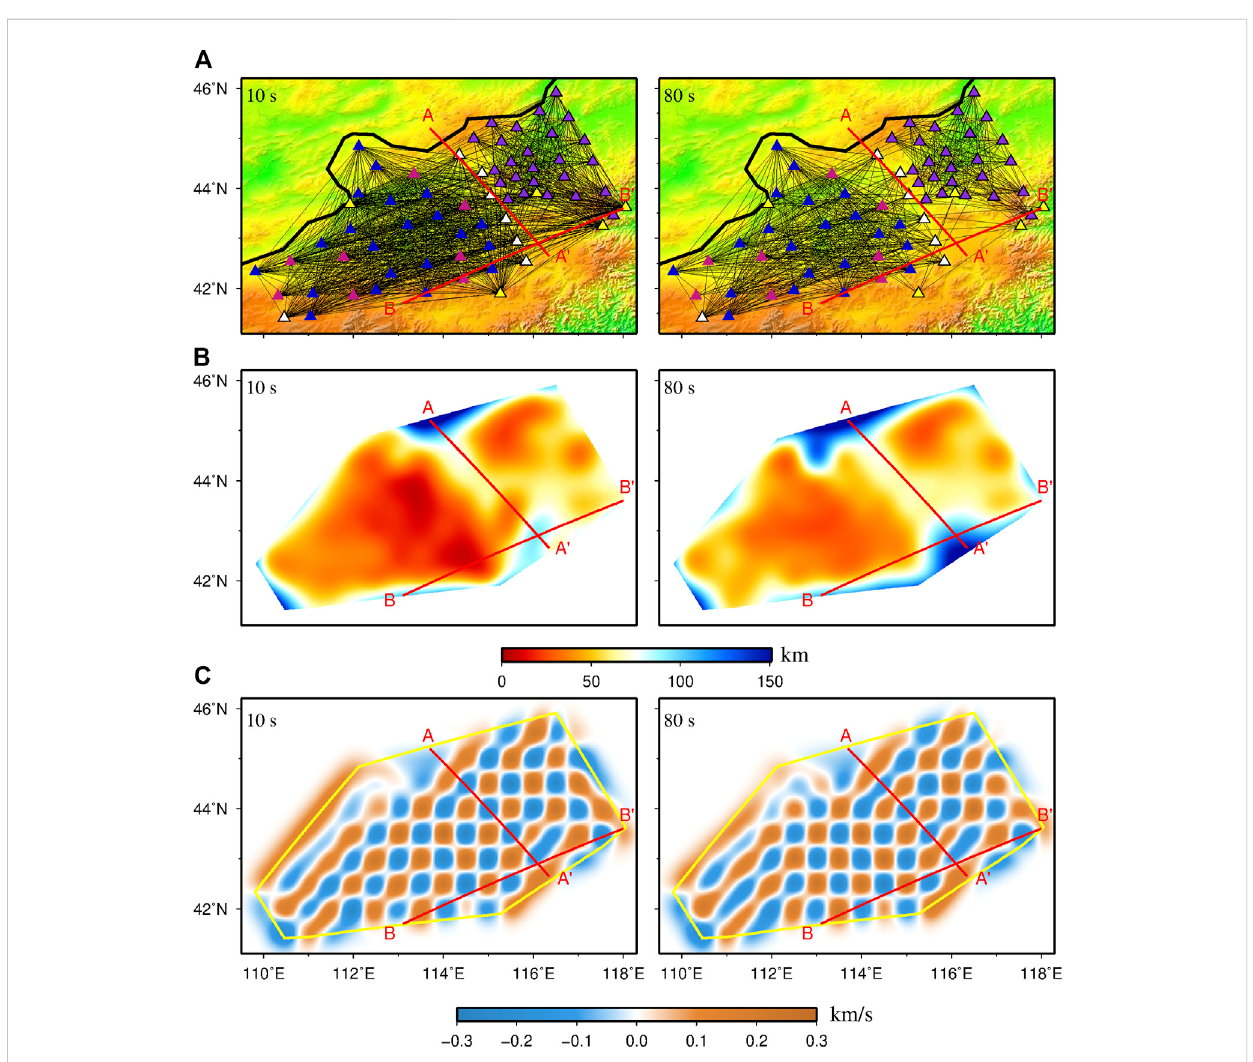
FIGURE 4 (A) Distribution ofpathsforRayleigh-wave phasevelocitymeasurementsat10 sand80 s.Trianglesindicateseismicstations,theblacklinebetween two stations indicates that there is a path coverage between this station pair. (B) Horizontal resolution map at 10 s and 80 s. The color- fi lled area is the station distribution area. (C) Checkerboard test at 10 s and 80 s. On Figures 4A,B and 4 (C) , the red straight line represents the position of pro fi les AA ’ and BB ’